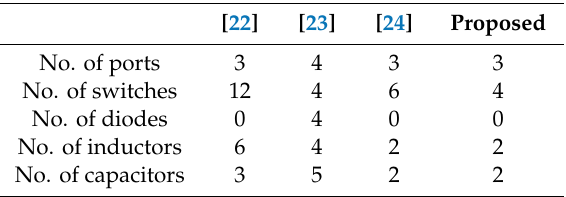
Table 1. Comparison of the converters.